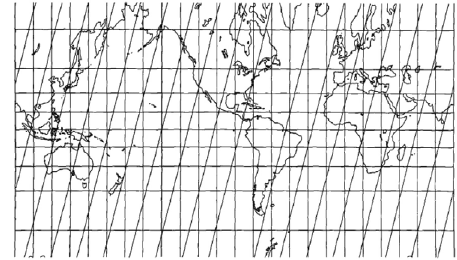
Fig. 9. Cylindrical Satellite-Tracking projection (J.P. Snyder 1987)